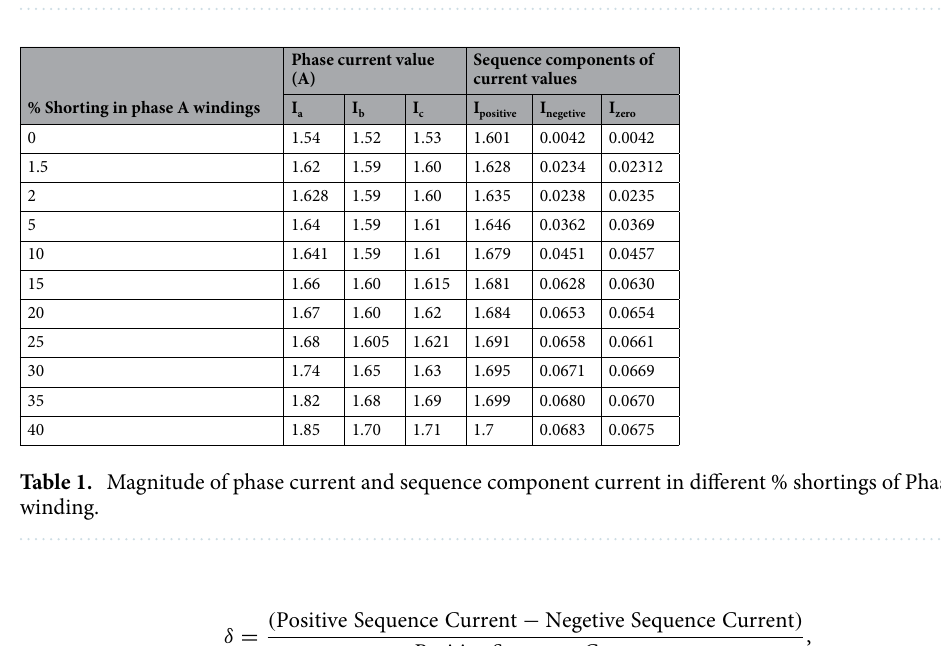
Figure 2. Simulink model of induction motor-based centrifugal pump.